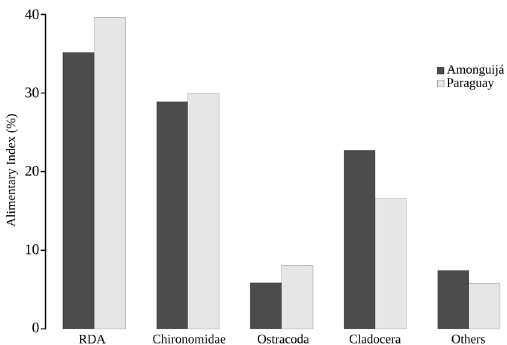
Figure 2. Alimentary Index for Eigenmannia desantanai in the Amonguijá and Paraguay Rivers at Porto Murtinho, MS, southern Pantanal,